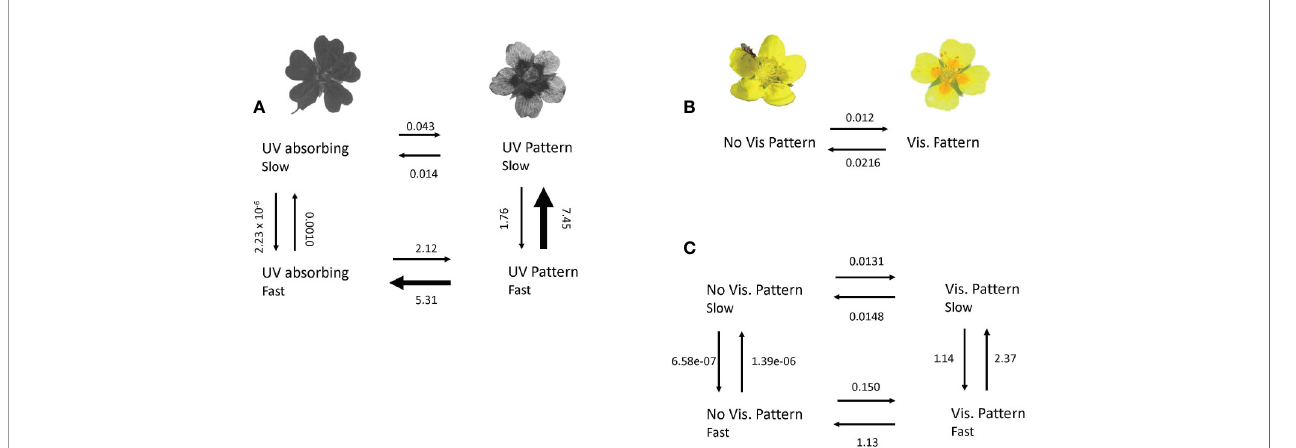
FIGURE 2 | Evolutionary transition rates among patterned and patternless fl owers in (A) the UV spectrum given the best fi t model of a single hidden rate, (B) the human-visible spectrum given a model with no hidden rates, and (C) the human visible spectrum given a model with a single hidden rate. The single hidden rate model for visible pattern is a marginally better fi t than the model without a hidden rate ( P = 0.054). Arrow widths are proportional to rates. Rates are presented in events per million